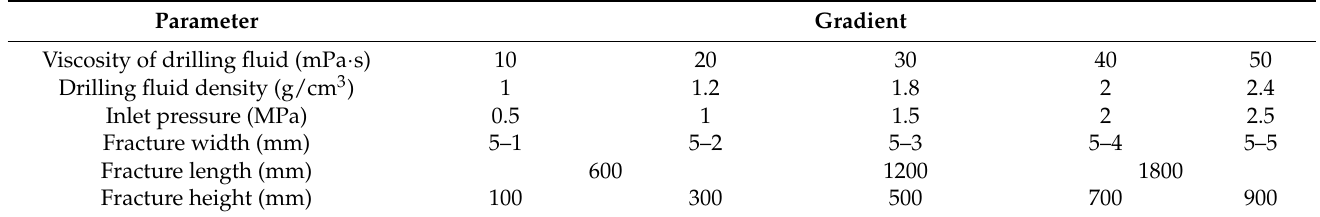
Table 1. Analog input parameters .